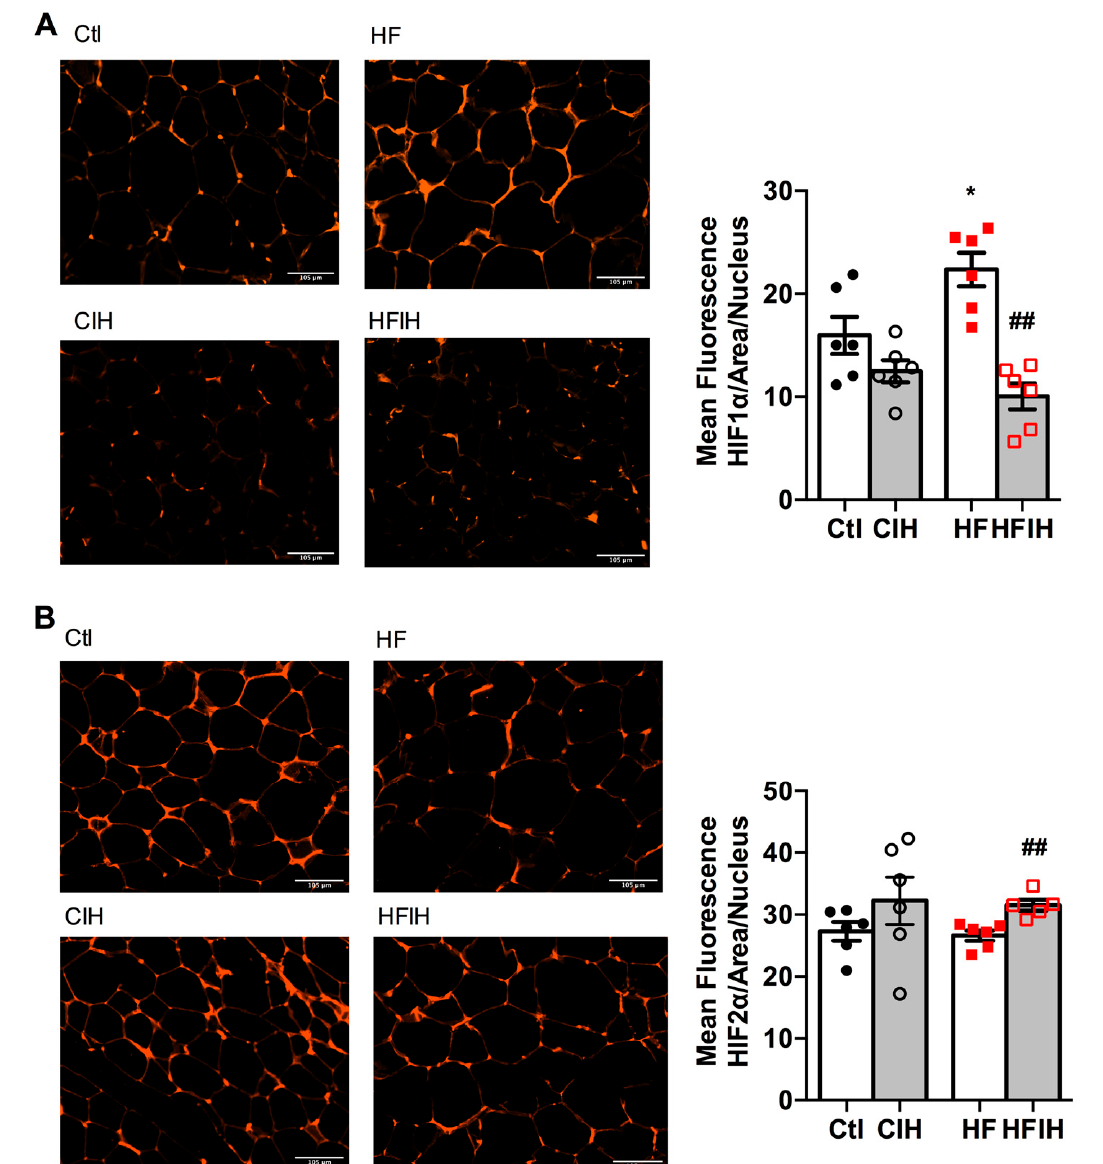
Figure 3. Effect of chronic intermittent hypoxia (CIH/IH) exposure on adipose tissue hypoxia in control and high-fat (HF) animals. ( A , B ) Immunofluorescence images for the hypoxia-inducible factor 1- and 2-alpha (HIF-1 α and HIF-2 α ) immuno-positive staining, respectively, on adipose tissue ( right panels) and the mean fluorescence of HIF-1 α and HIF-2 α , normalized for the number of nucleus ( left panels) present in the adipose tissue of control and HF animals. Data are presented as means ± SEM of 5–6 animals. One- and two-way ANOVA with Dunnett’s and Bonferroni multiple comparison tests, respectively: * p < 0.05 compared with control animals; ## p < 0.05 compared values with HF animals without CIH.